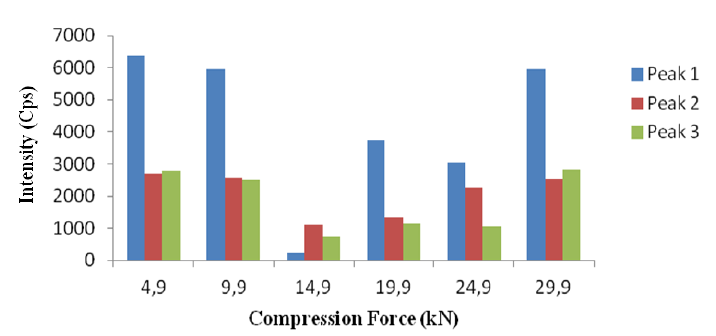
Figure 5. Intensity of three specific peaks of compressed 4:6 weight ratio ibuprofen-stearic acid binary mixture under different compression